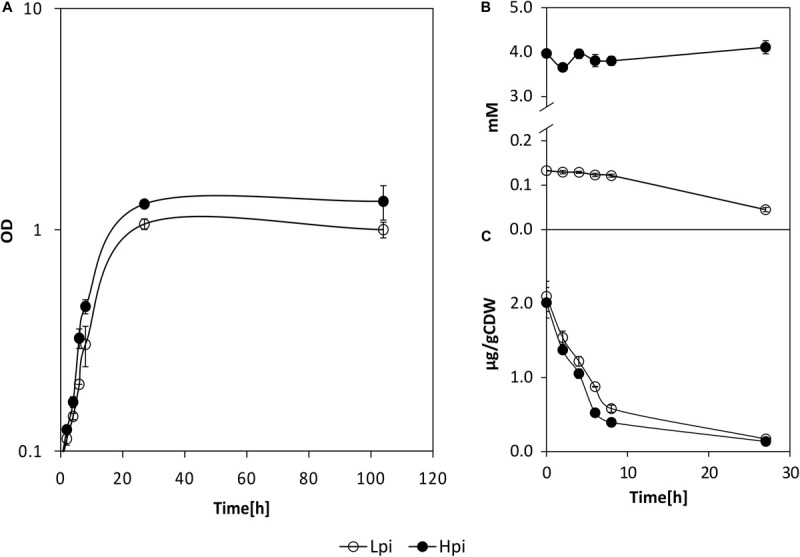
Growth (A) and orthophosphate concentrations in the supernatants (B) and cell lysates (C) of P. sonchi SBR5 cultivated in high phosphate medium (HPi, closed circles) or low phosphate medium (LPi, open circles). CDW, cell dry weight. Data given as means and standard deviations of biological triplicates.